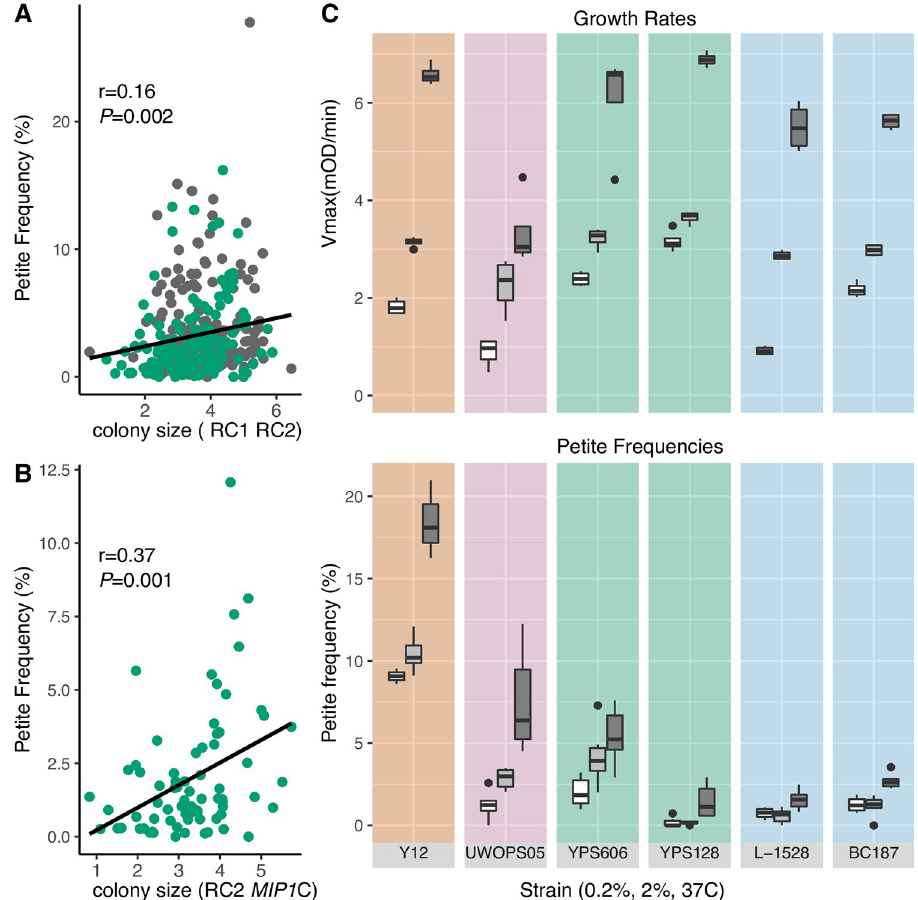
Fig 7. Rapid mitotic growth increases rates of mtDNA loss. Growth of A . RC1 and RC2 strains and B . RC2 strains with the low petite frequency MIP1 allele (943237C) are positively correlated with spontaneous petite frequencies. Colony sizes (arbitrary units) are reported as differences in colony size formation on solid media. C . Growth rates and petite frequencies increased as a result of increased glucose concentration and temperature. Growth rates (top panel) and petite frequencies (bottom panel) were measured for 6 strains in media containing low 0.2% (white boxes) or 2% (medium gray boxes) glucose at 30C and in 2% glucose at 37C (dark gray boxes). Shaded backgrounds indicated parental populations as in Fig 1 . Vmax was estimated from regression lines modeled from growth curves in liquid